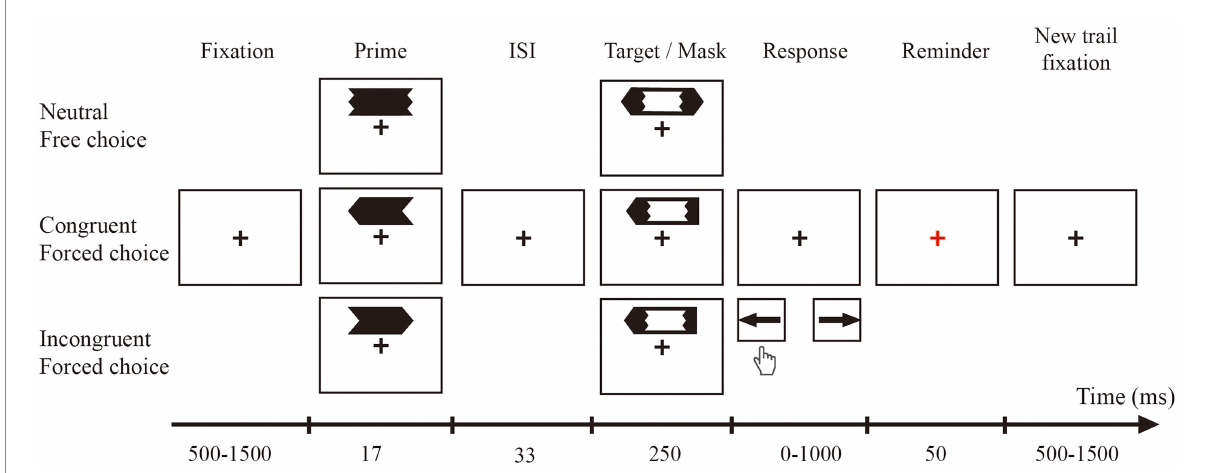
FIGURE 1 Schematic of the trial procedures and stimuli in the pre-and post-test tasks. Three example trials of the possible combinations showing the choice type (free: upper row; forced: middle and lower row) and prime target congruency (neutral: upper panel; congruent: middle panel; incongruent: lower panel). The participants were instructed to respond to the target stimuli while being unaware of the presence of the arrow primes. Primes and targets could appear randomly above or below their fixation point during each trial, and the orientation of each stimulus was horizontal. In the illustrations in the article, the background is shown as white, and the stimuli are shown in black to enhance legibility. However, in the actual experiment, the background was black, and the stimuli were